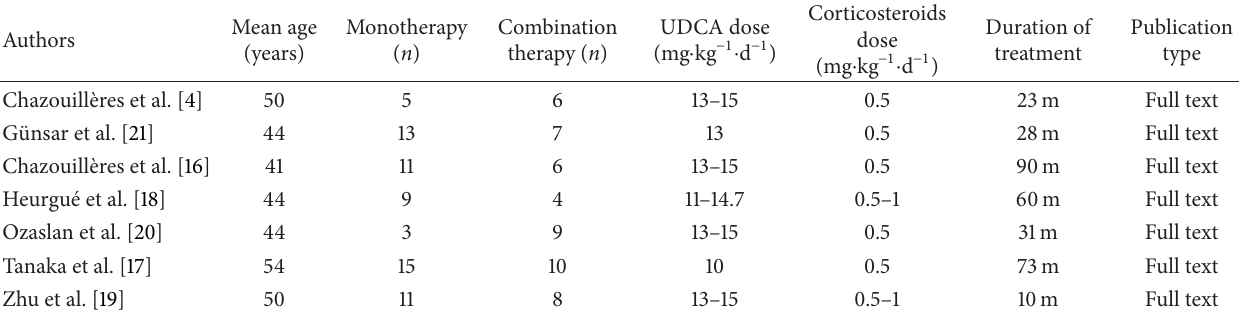
Table 2: Baseline characteristics of the trials included in the